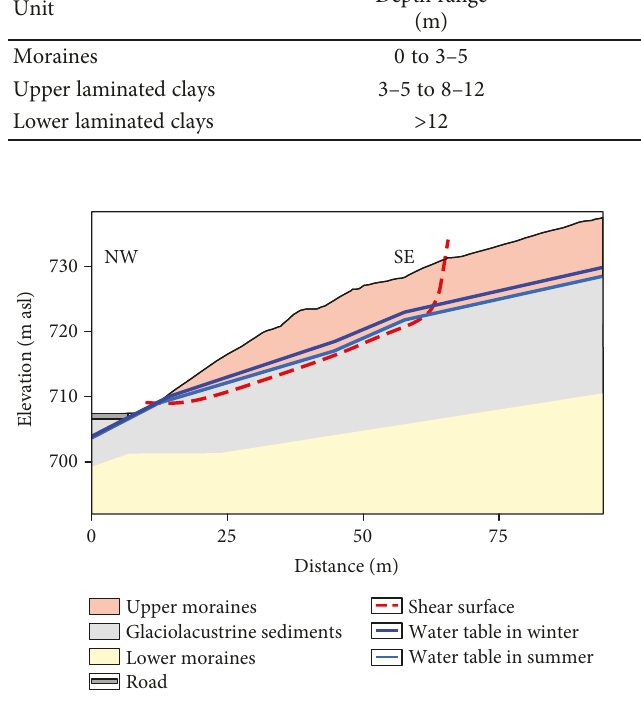
Figure 7: Geotechnical model and hydrogeological conditions used for stability calculations considering the shear surface at 12m depth only.